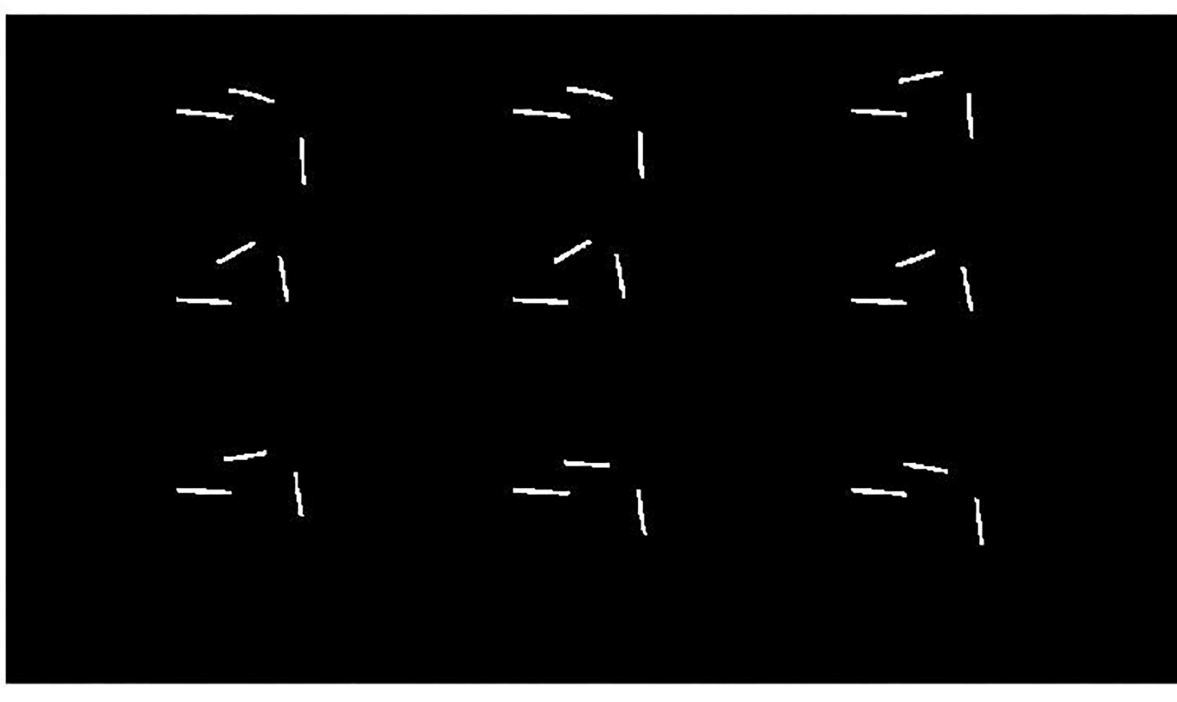
required pixels in the pixel coordinate system, combined with their depth values, are transformed into the camera coordinate system for description, and the coordinate in the camera coordinate system can be obtained, where the maximum value of i is equal to k , which is the number of